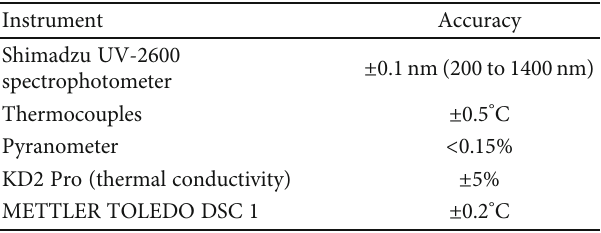
Table 4: Speci fi cations of the instruments used in the experiment.